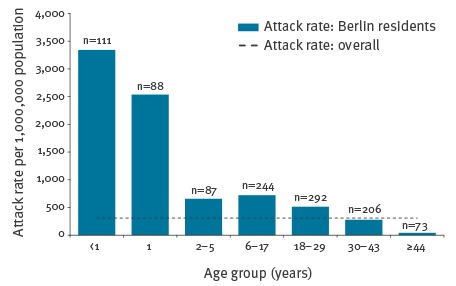
Attack rates per 1,000,000 by age group among the resident population in a large outbreak of measles in Berlin, October 2014–August 2015